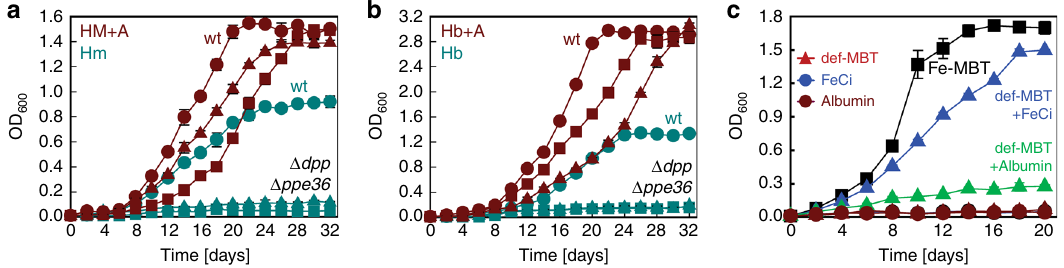
Fig. 8 Albumin alters heme and hemoglobin utilization in M. tuberculosis . Growth of avirulent Mtb strain mc 2 6206 (wt; circles), Δ ppe36 (triangles), and Δ dpp (squares) in HdB minimal medium without (cyan) or with 0.5% bovine serum albumin (red) containing 10 µ M hemin ( a ) or 2.5 µ M human hemoglobin ( b ) as sole iron sources. All hemin and hemoglobin media contained 20 µ M 2,2 ′ -dipyridyl to prevent utilization of trace ferric iron. Error bars represent standard errors of mean values of biological triplicates. c Growth of avirulent Mtb mbtD mutant strain ML1600 in HdB minimal medium containing 10 µ M ferric mycobactin (Fe-MBT; black squares), 10 µ M ferric citrate (FeCi; blue circles), 10 µ M FeCi and 10 µ M deferrated MBT (def-MBT + FeCi; blue triangles), 10 µ M def-MBT (red triangles), 0.5% albumin (green circles) and 10 µ M def-MBT and 0.5% albumin (green triangles). Error bars represent standard errors of mean values of biological triplicates. Note: Data points for def-MBT (red triangles), FeCi (blue circles), and albumin (green circles) overlap. Source data are provided in the Source Data